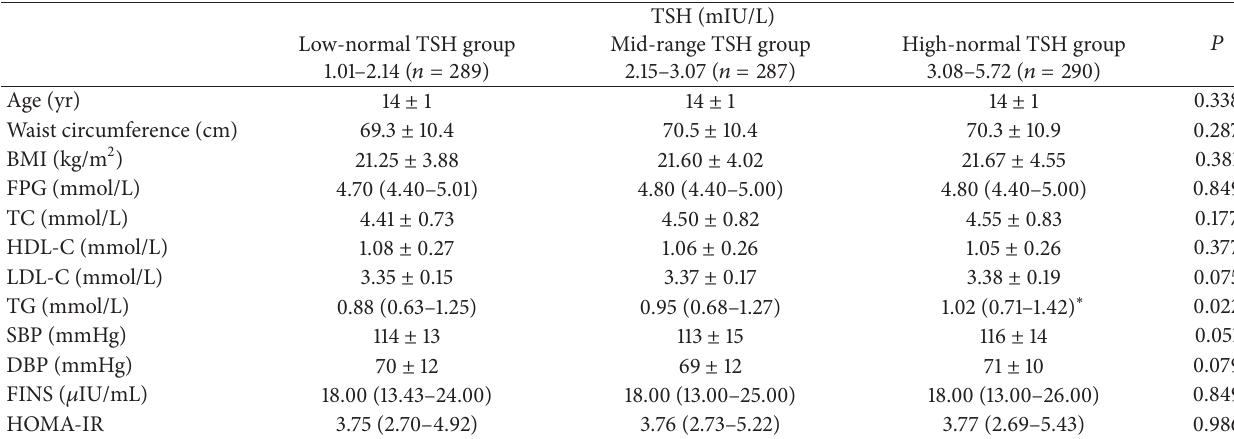
Table 4: Comparison of the components of metabolic syndrome in groups with normal TSH